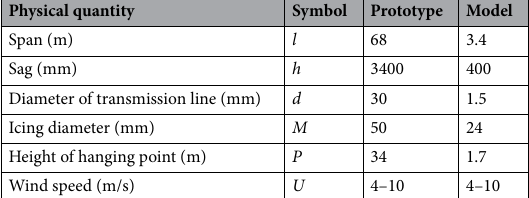
Table 2. Dimensions of prototype and model